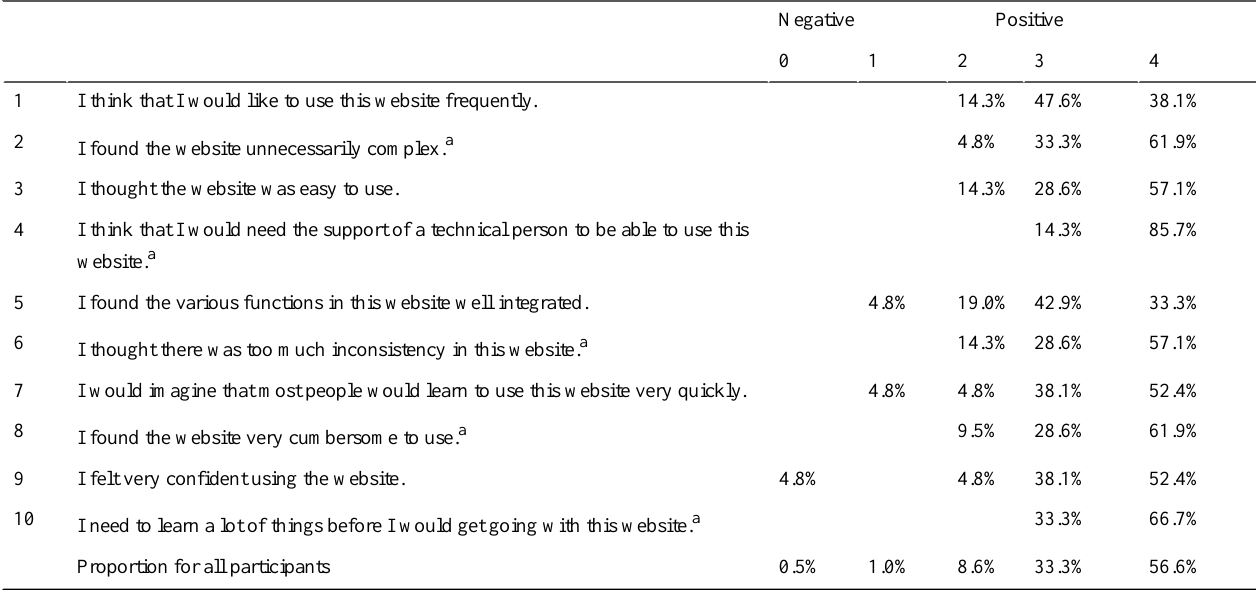
Table 1. System Usability Scale item responses: Combined sample (N=